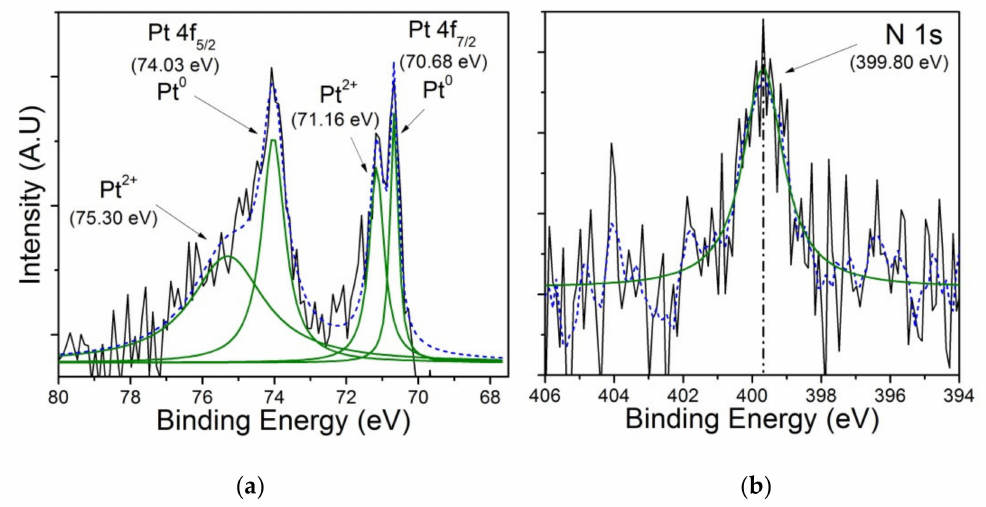
Figure 5. XPS spectra of the sample N-TiO 2 − x /Pt after 2 h nitrogen plasma treatment: ( a ) Pt and ( b )